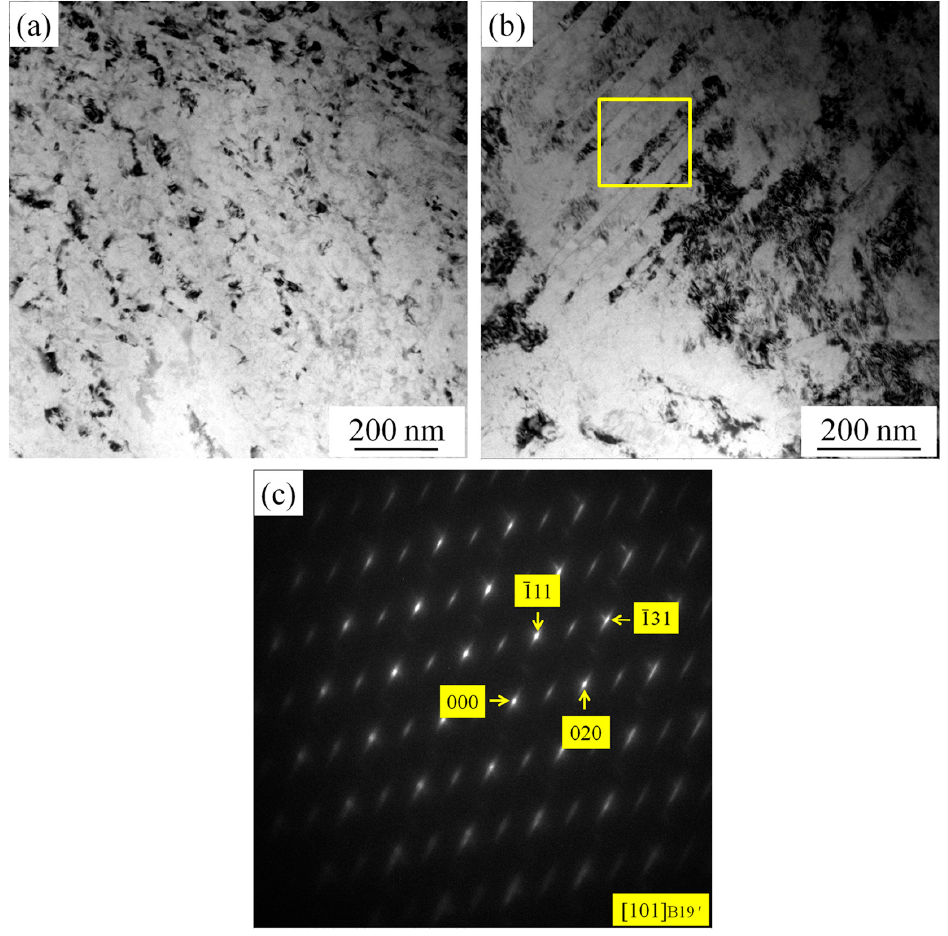
Figure 8. TEM micrographs of NiTiCu SMA subjected to compression deformation at 1000 °C: ( a ) Bright field image showing no martensite laths; ( b ) Bright field image showing the existence of martensite laths; ( c ) Diffraction pattern of (b).